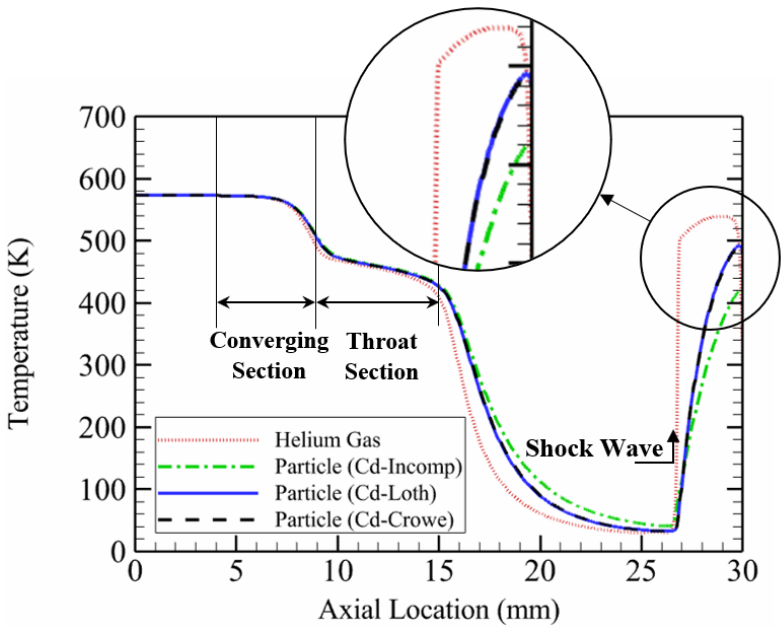
Figure 12. Effect of drag coefficients on centerline particle temperature, 𝑑 𝑝 = 1 μm .